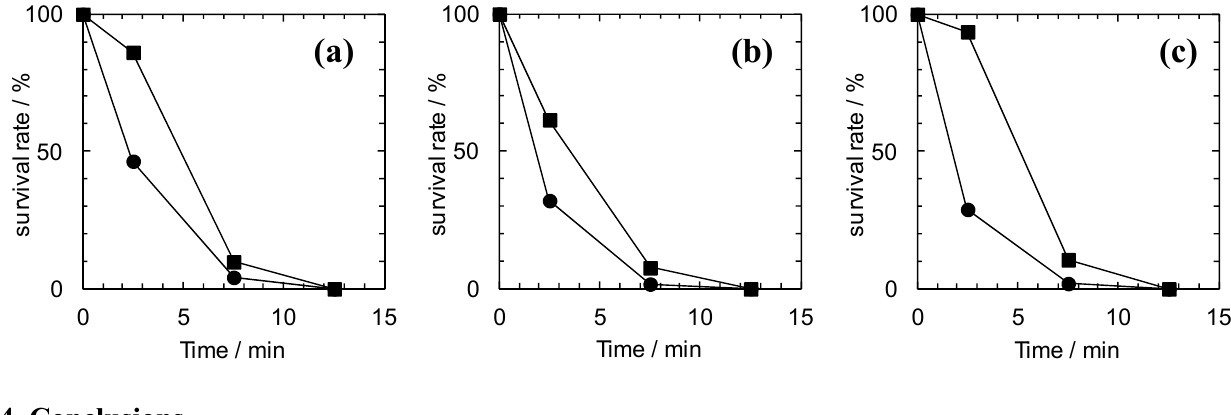
Figure 9. Time course of survival rate of ( a ) SPC; ( b ) TC; and ( c ) E. coli in the water purification system. Solid squares: O reactor (10